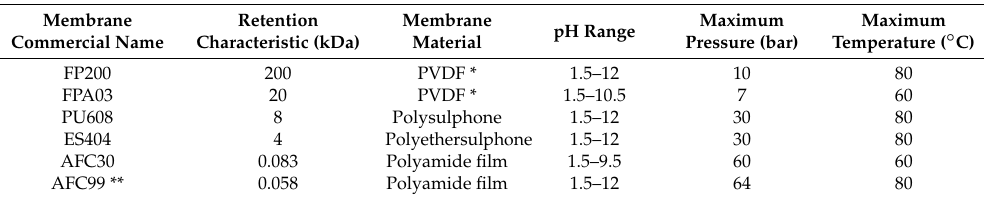
Table 1. Membrane characteristics [20].